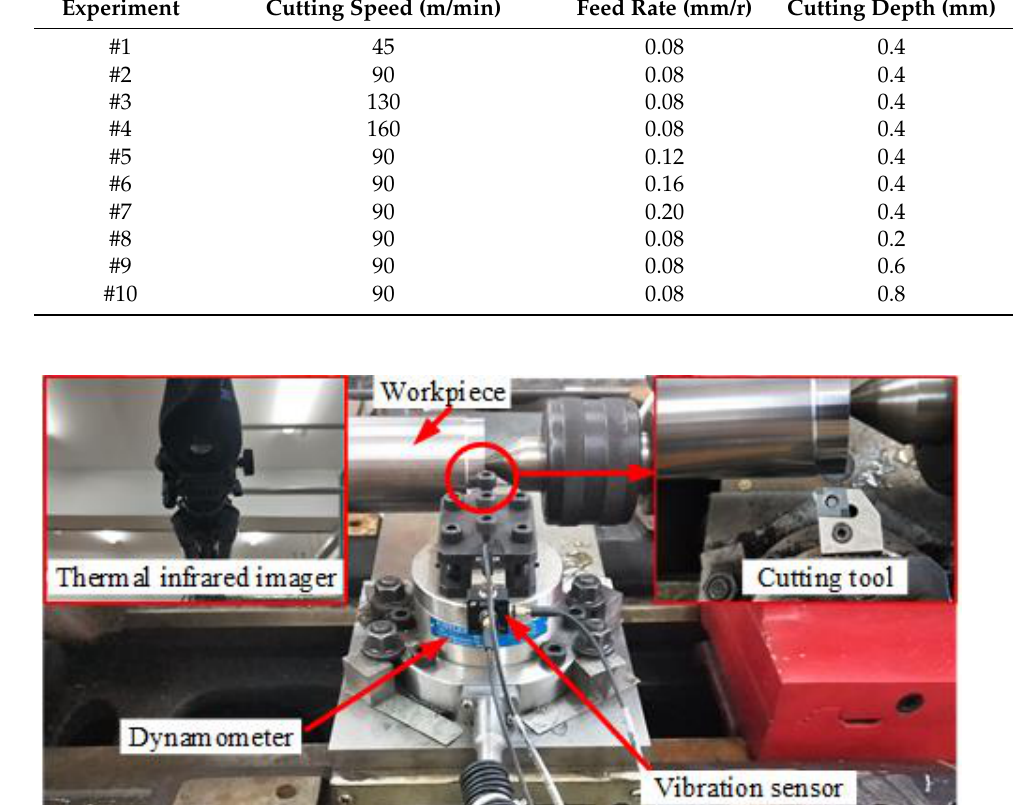
Figure 1. Photographic view of hard turning experiment.